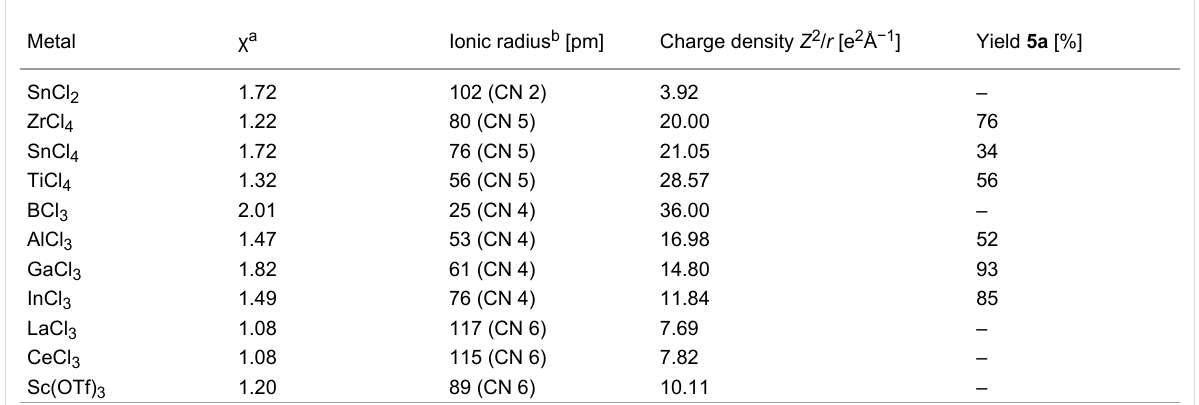
Table 9: Effect of the properties of metals on the yields of 5a (reaction time: 2